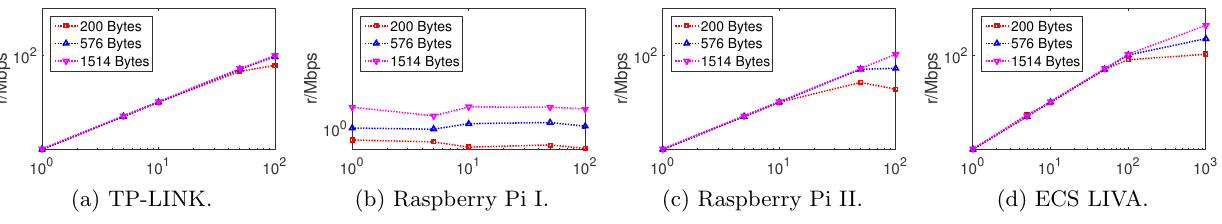
Figure 3: The log-log plot of measured packet sending rate r against the expected without cross-traffic.